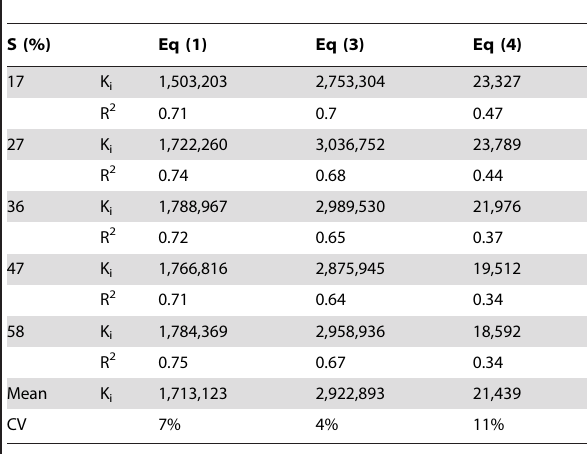
Table 3. Interrill erodibilities ( K i ) and coefficients of determination ( R 2 ) for Eqs. (1), (3), and (4) for different slope gradients.